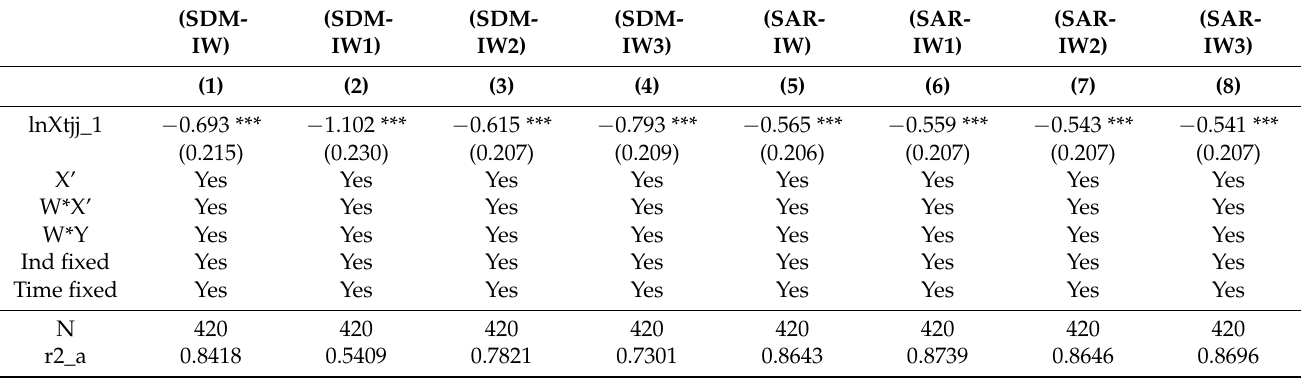
Table 7. The results of endogenous